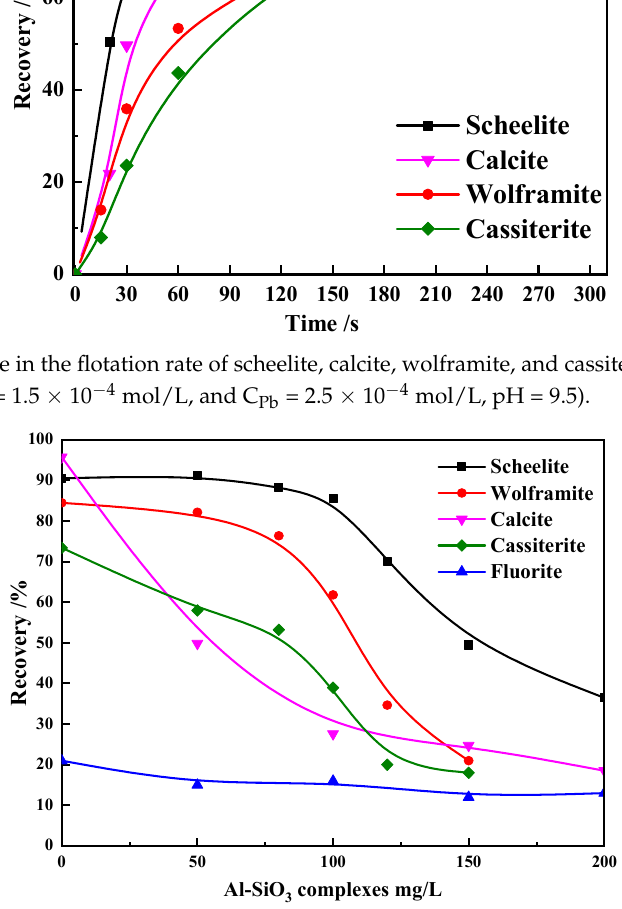
Figure 4. Effects of Al-SiO 3 complexes on the flotation of different minerals using Pb–BHA complexes as the collector (C BHA = 1.5 × 10 −4 mol/L, and C Pb = 2.5 × 10 −4 mol/L, pH = 9.5).